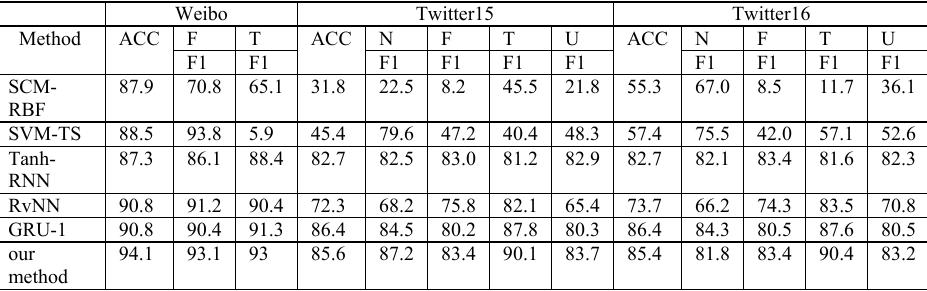
Table 2. The experimental results of these three data